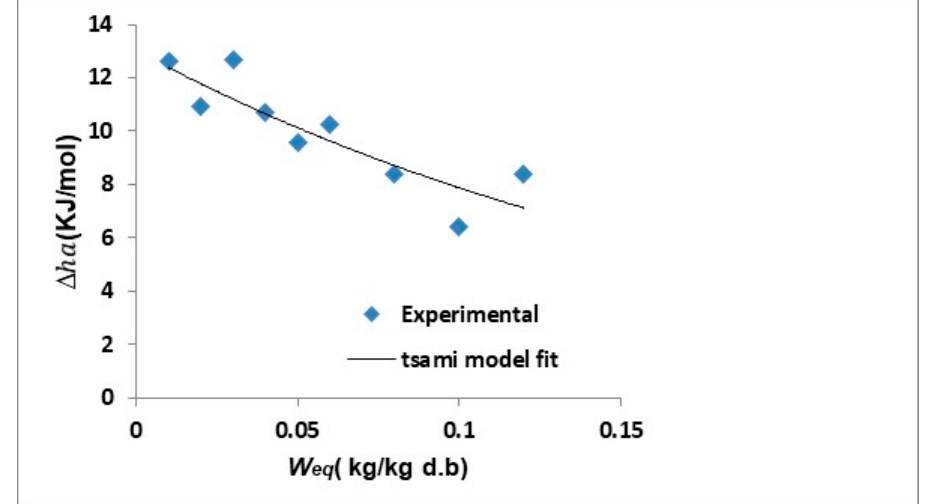
Figure 12. Isosteric heat of water desorption from corn kernels as a function of equilibrium moisture content W eq .